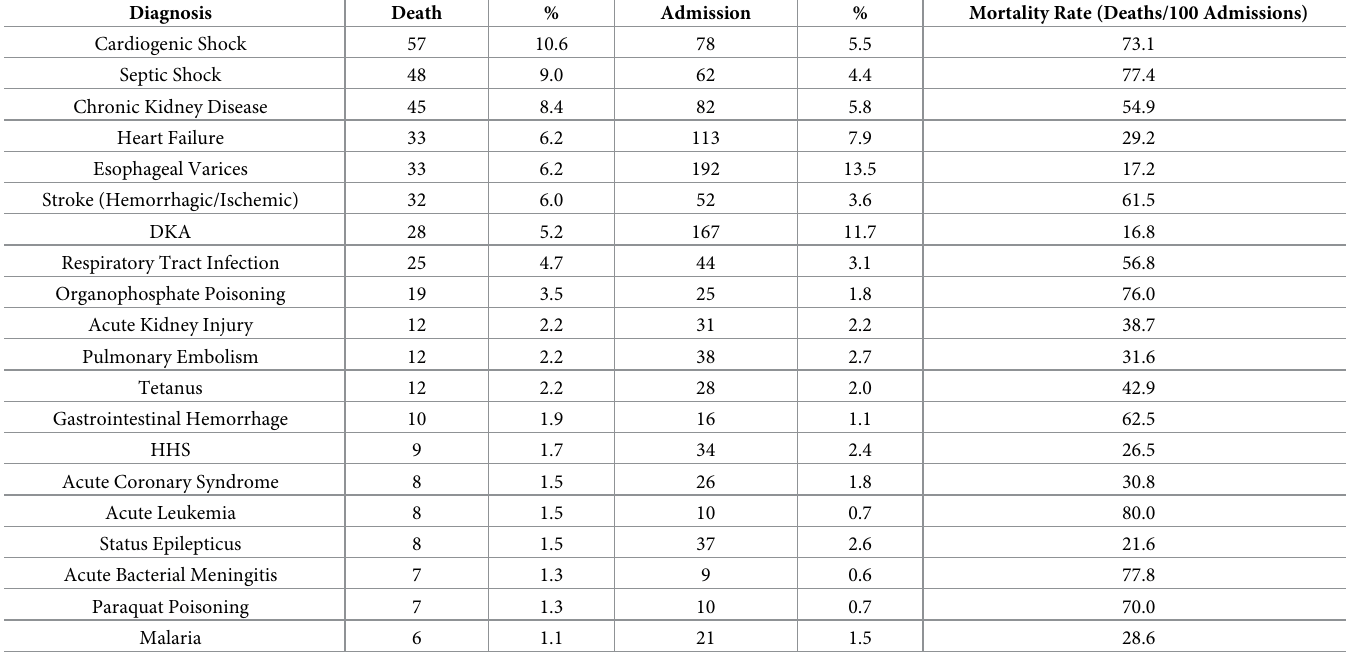
Table 2. In-Hospital mortality of the leading causes of death in the